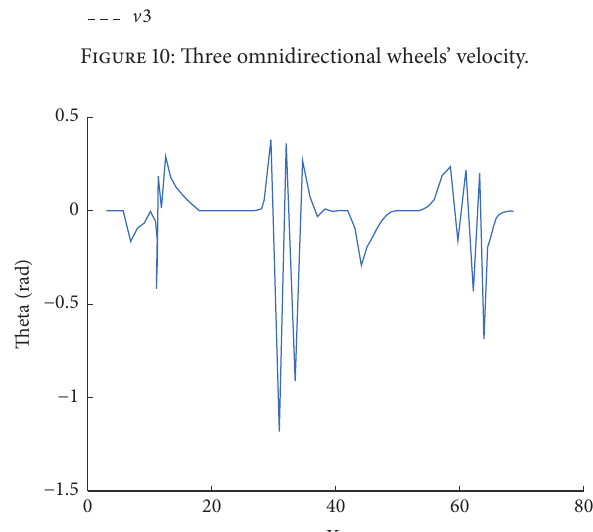
Figure 14: The velocity of the OMR controlled by dynamics controller during the simulation.